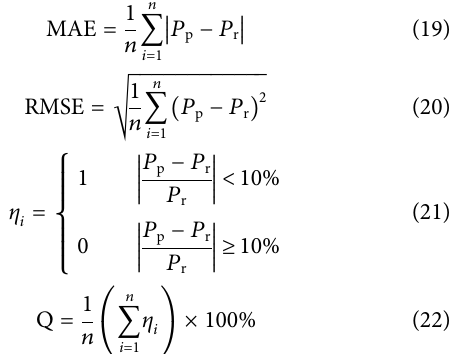
FIGURE 4 | Prediction fl ow chart based on fl uctuant/smooth components